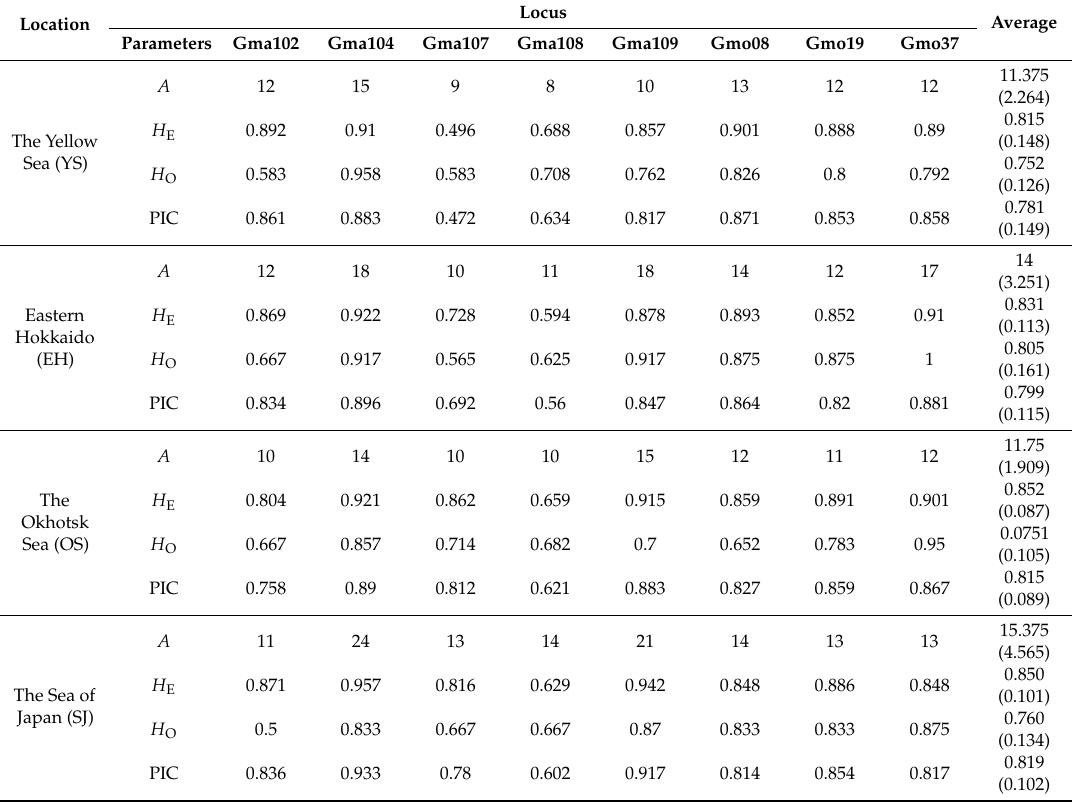
Table 1. Genetic diversity indices for Pacific cod.